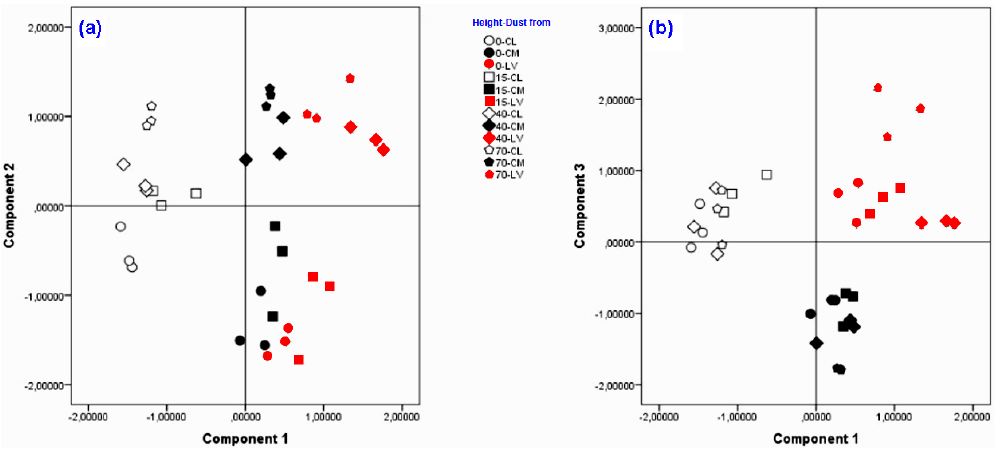
Figure 5. Scatter plot of the height–dust from Calcisols (CL), Cambisols (CM) and Luvisols (LV) categories for the components 1 and 2 matrix (a) and the components 1 and 3 matrix (b) .